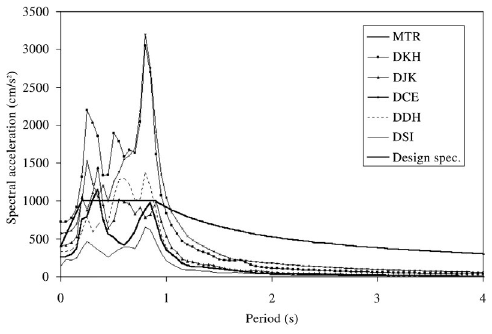
Fig. 10. Comparison of the 5% damped synthetic response spectra with the observed response spectra at MTR for the Dinar earthquake, and the elastic de- sign spectra defined in the Turkish code for similar seismic zone and soil characteristics. Reference base motion for the synthetics was obtained by deconvo- lution of the mainshock at MTR station with the cor- responding 2D transfer function for this station, and then the base motion was convoluted with the corre- sponding transfer function at each location for the surface